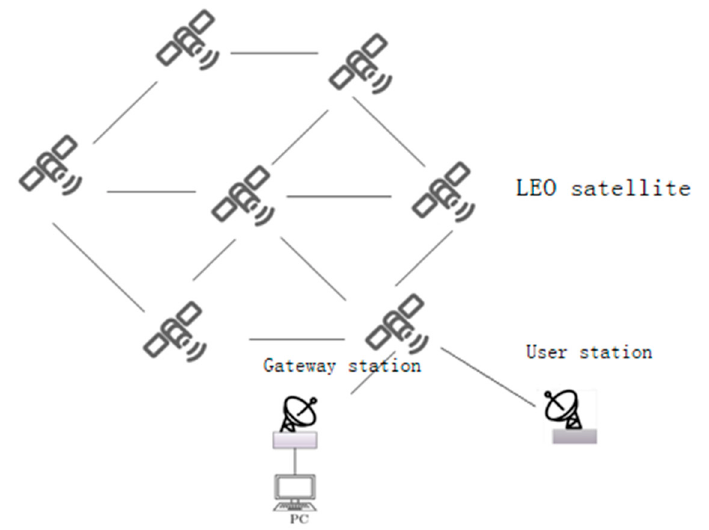
Figure 1. Schematic diagram of inter-satellite link.